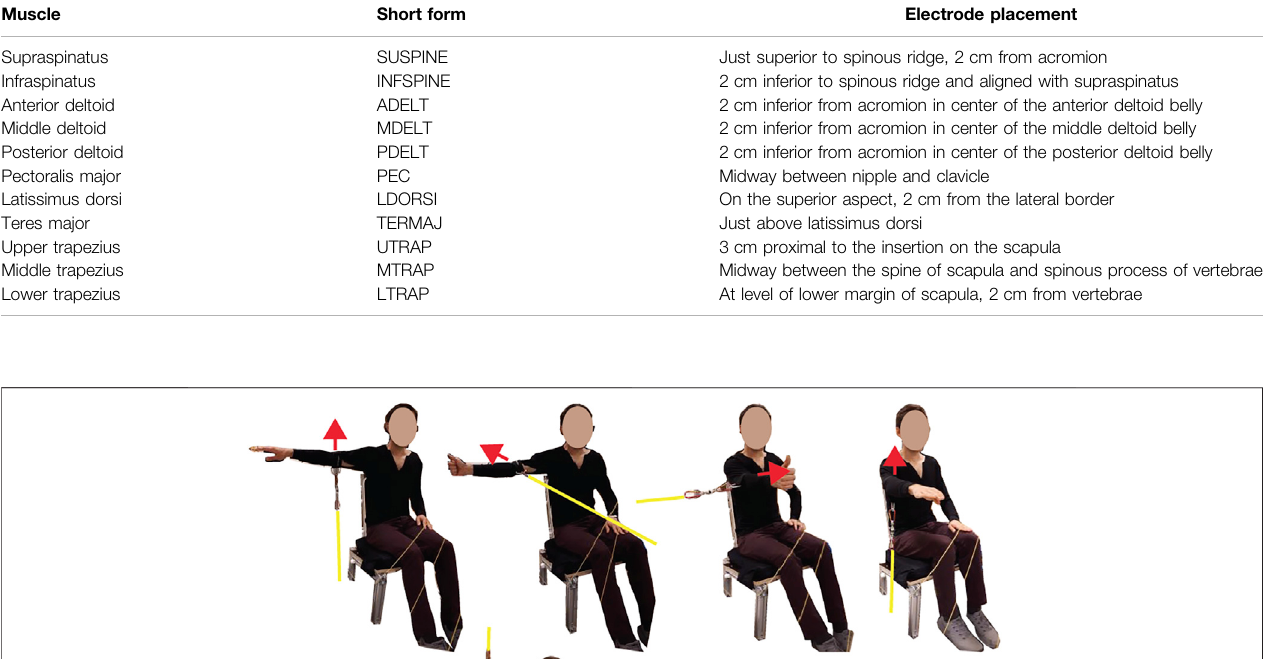
Frontiers in Bioengineering and Biotechnology |